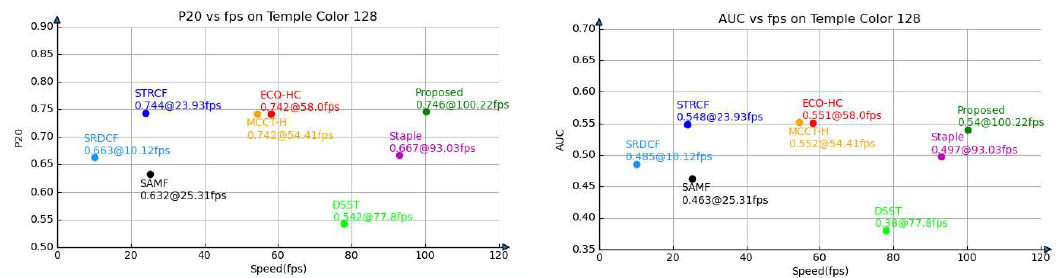
Figure 8. Performance-efficiency plot on Temple Color 128 of CRCF_ATU tracker and existing trackers.